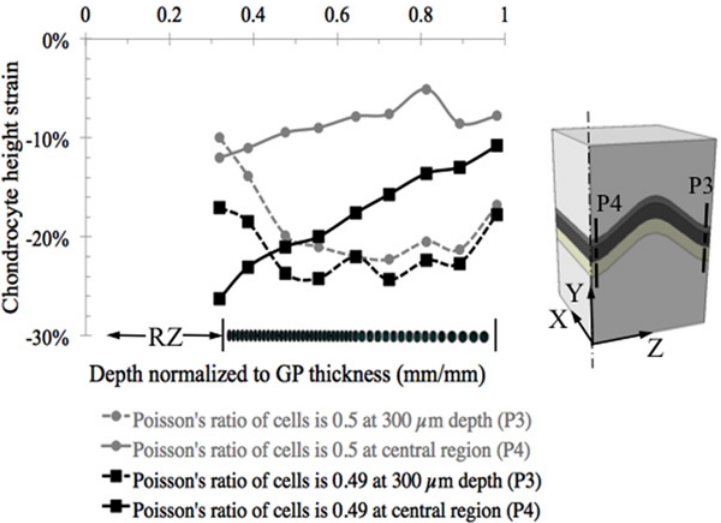
Fig 10. Results for two cases with the cellular Young ’ s modulus increased 20-fold over the instantaneous short time scale value, for cellular Poisson ’ s ratio = 0.50 and 0.49 in an effort to approximate long-time scale compression with a purely elastic approach to compare with the experimental values in the literature. Results are very sensitive to assumed values of cellular Poisson ’ s ratio and to the Young ’ s modulus ratio between the cell and the tightly bound territorial matrix and we do not believe this is the correct approach for modeling long-time scale events since the real value of cellular Poisson ’ s ratio cannot be accurately